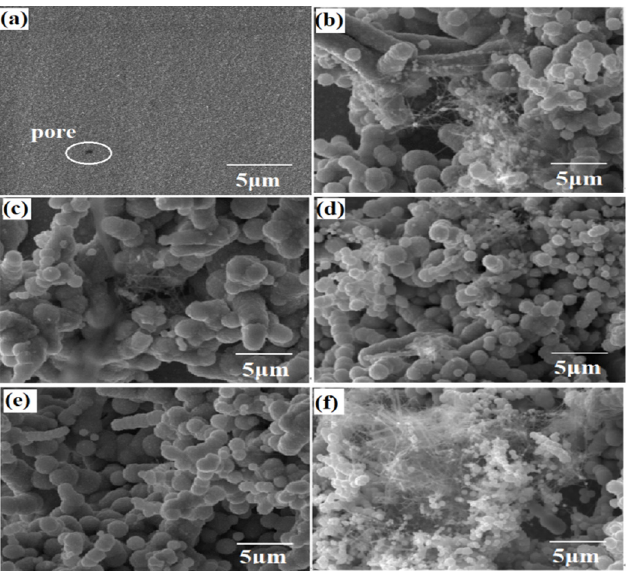
Figure 1. Surface morphology of composite coatings deposited at ( a ) 0 g/L, ( b ) 0.1 g/L, ( c ) 0.2 g/L, ( d ) 0.3 g/L, ( e ) 0.4 g/L and ( f ) 0.5 g/L CF.